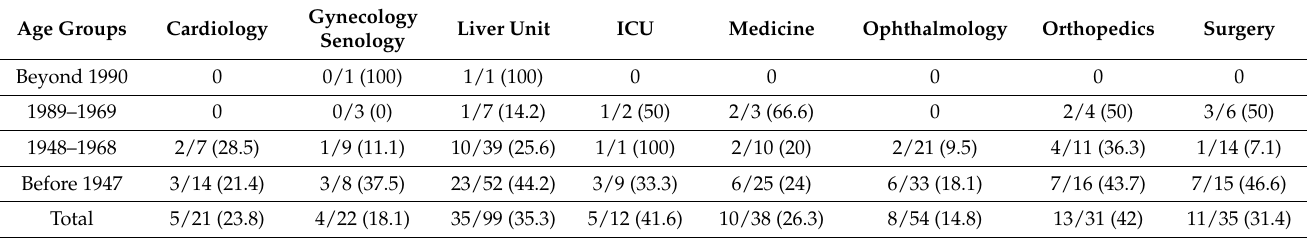
Table 1. HCV active infection among patients tested between different hospital divisions.